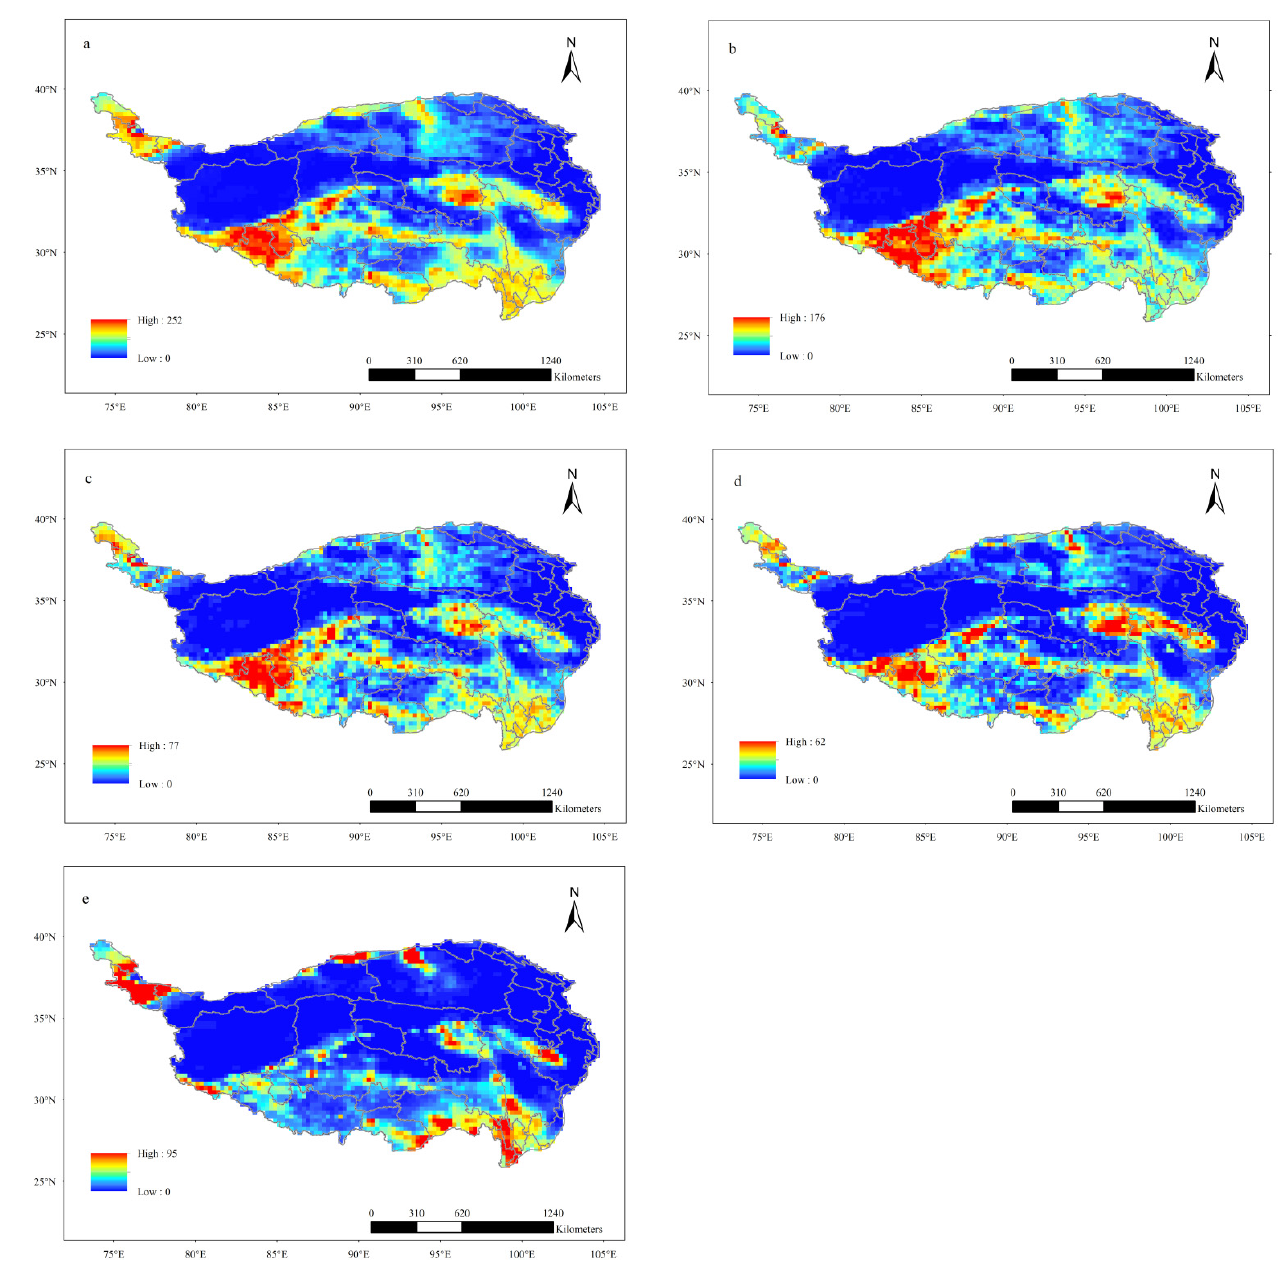
Figure 5. Spatial distribution of frequencies of different grades of snow disasters on the QTP over the past 40 years (( a – e ) represent total snow disasters, slight, moderate, heavy, and extremely heavy snow disasters, respectively).